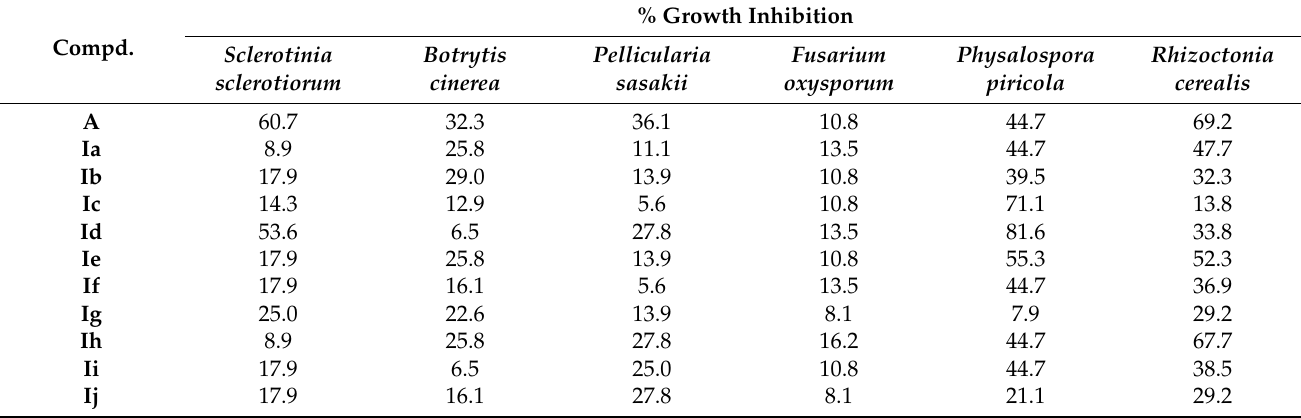
Table 3. In vitro fungicidal activities of the target compounds A and Ia–q at 50 µ g/mL.